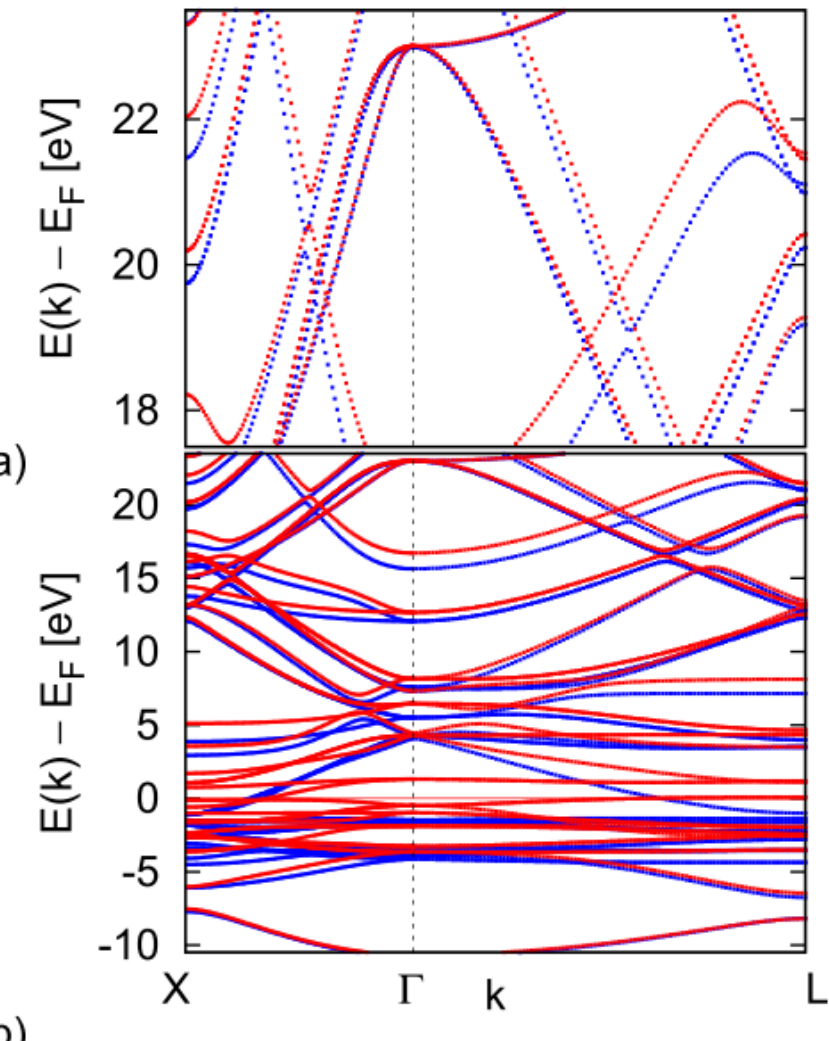
Figure 4. Spin-resolved band structure of austenite phase of Ni 2 MnGa. ( a ) Detail of energy range around the value of excitation radiation energy, 21.28 eV, employed for experimental measurements. ( b ) Band structure in the larger energy range. Red lines denote minority spin bands while blue lines denote majority spin bands.